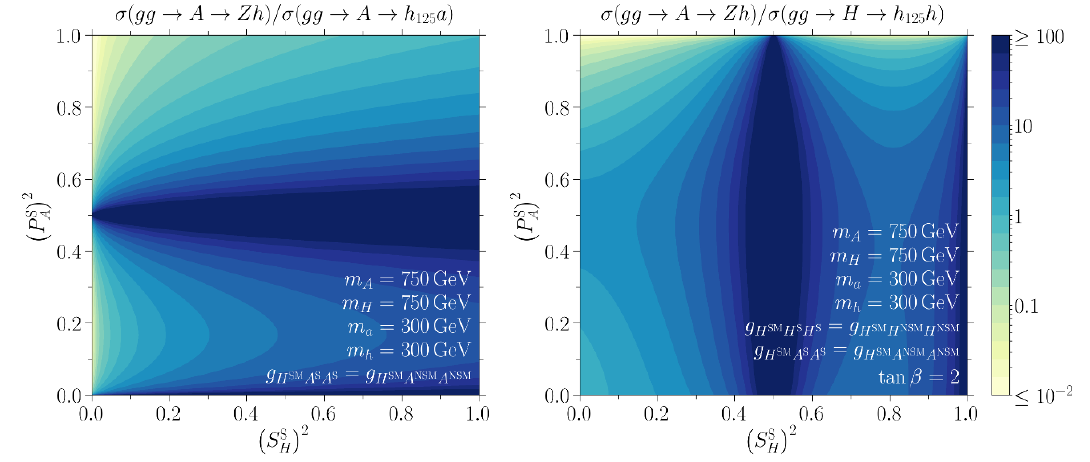
Figure 1 . The ratios of the labeled (cid:12)nal state cross sections for the Higgs cascades are shown in the plane of the singlet fraction of the parent CP-even and CP-odd heavy Higgs bosons, respectively. Left: [ (cid:27) ( gg A Zh ) =(cid:27) ( gg A h 125 a )], cf. eq. (2.76), Right: [ (cid:27) ( gg ! ! ! ! H h 125 h )], cf. eq. (2.77). The numerical values corresponding to the colors are displayed in the ! scale legend. Other relevant parameters are (cid:12)xed to the values indicated in the respective panels. In addition, the remaining trilinear couplings between Higgs basis eigenstates, including the ones which a(cid:11)ect the total decay widths of the heavy Higgs bosons A and H relevant for the right panel, are set to